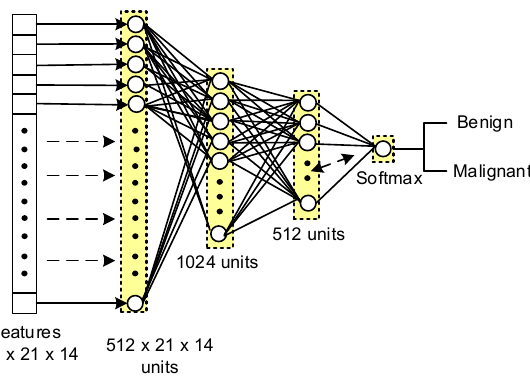
Figure 5. Configuration of learning phase.